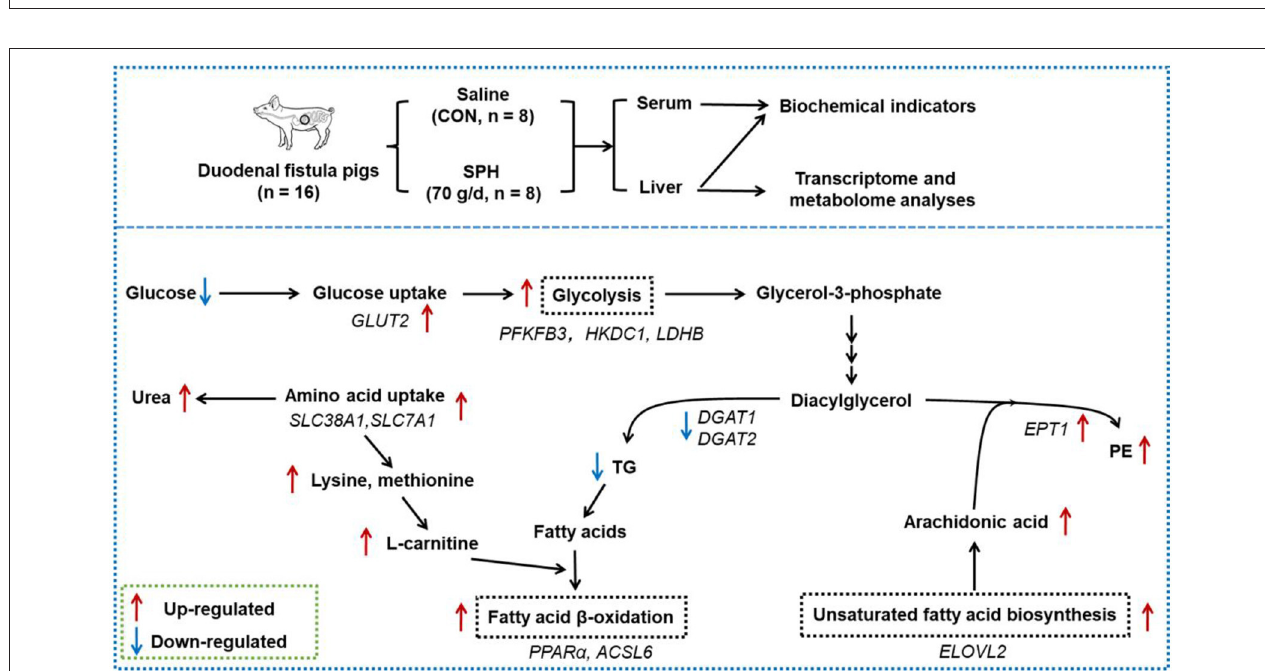
FIGURE 3 | qRT-PCR analysis of DEGs in the CON and SPH groups. Values are mean ± SEM ( n = 8). * P < 0.05.